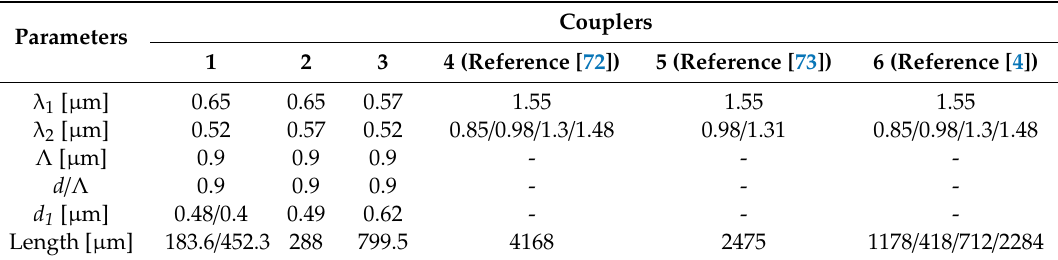
Table 1. Design parameters of the polymer optical fiber couplers.